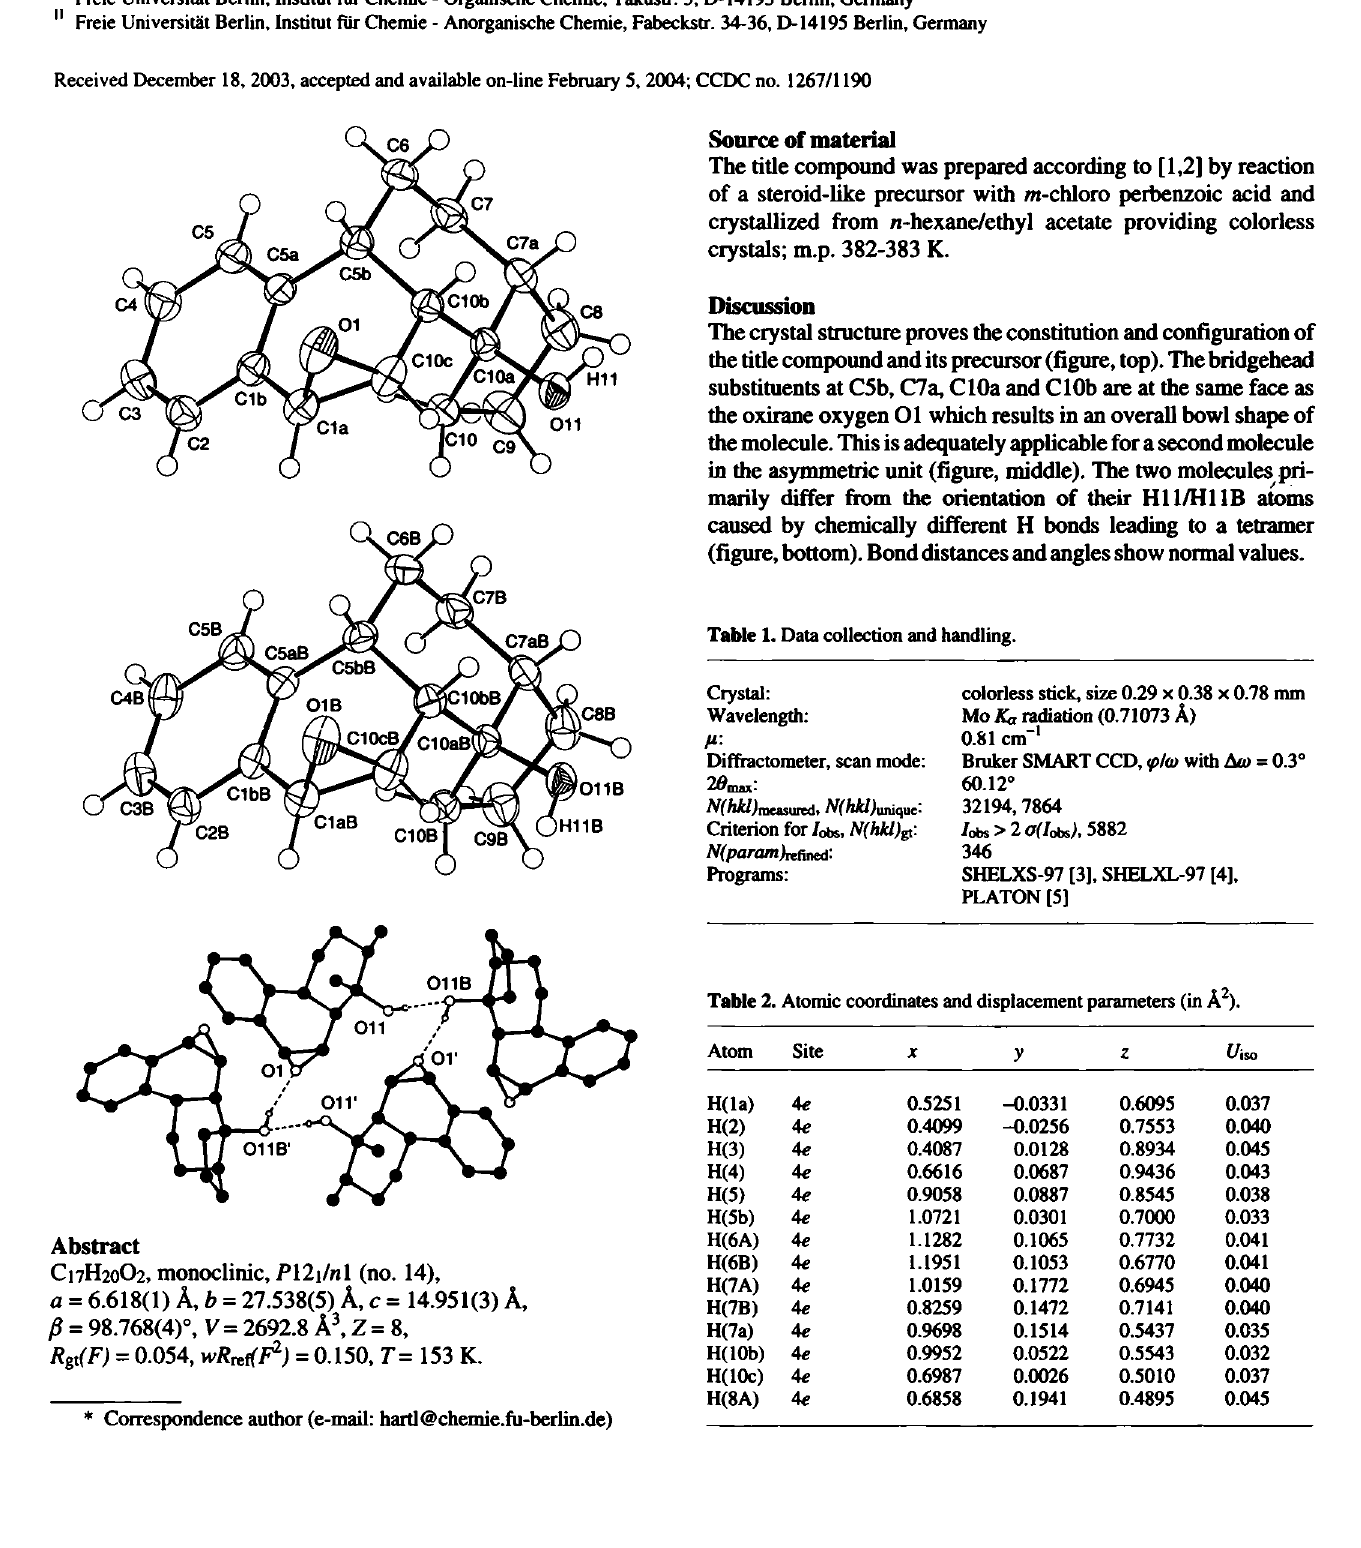
Table 2. Atomic coordinates and displacement parameters (in A 2